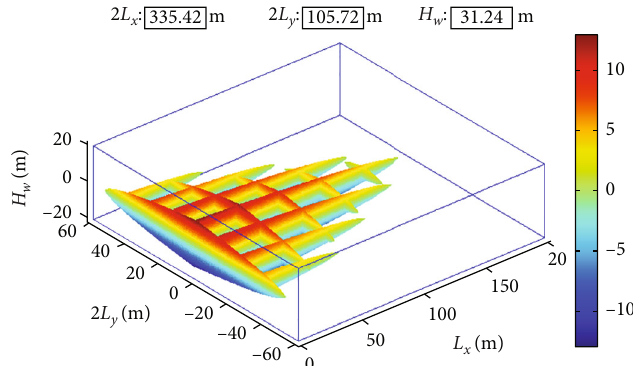
Figure 8: Numerical simulation results of the continuous fracture network. The change of color in the fi gure represents the change of fracture height.